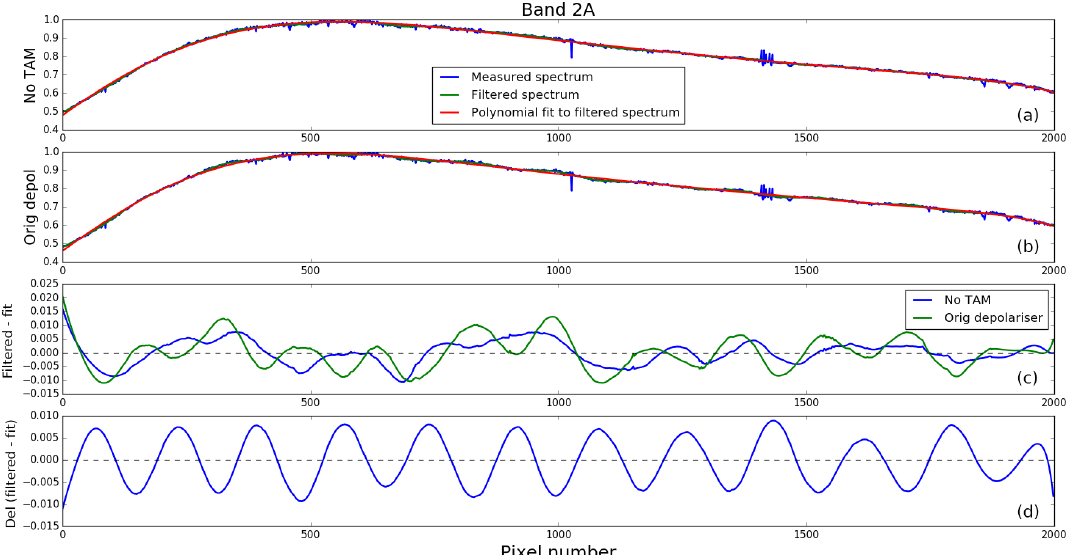
Figure A1. Uncalibrated Band 2A measurements of integrating sphere output. (a) Spectrum measured without the TAM in place (blue), which is then noise filtered (green) and approximated by a polynomial (red); (b) is the same as (a) but with the TAM in place; (c) difference between noise-filtered spectrum and the polynomial fit in each of the two cases; and (d) difference between the two residuals shown in (c) , isolating the effect of the depolarizer on the